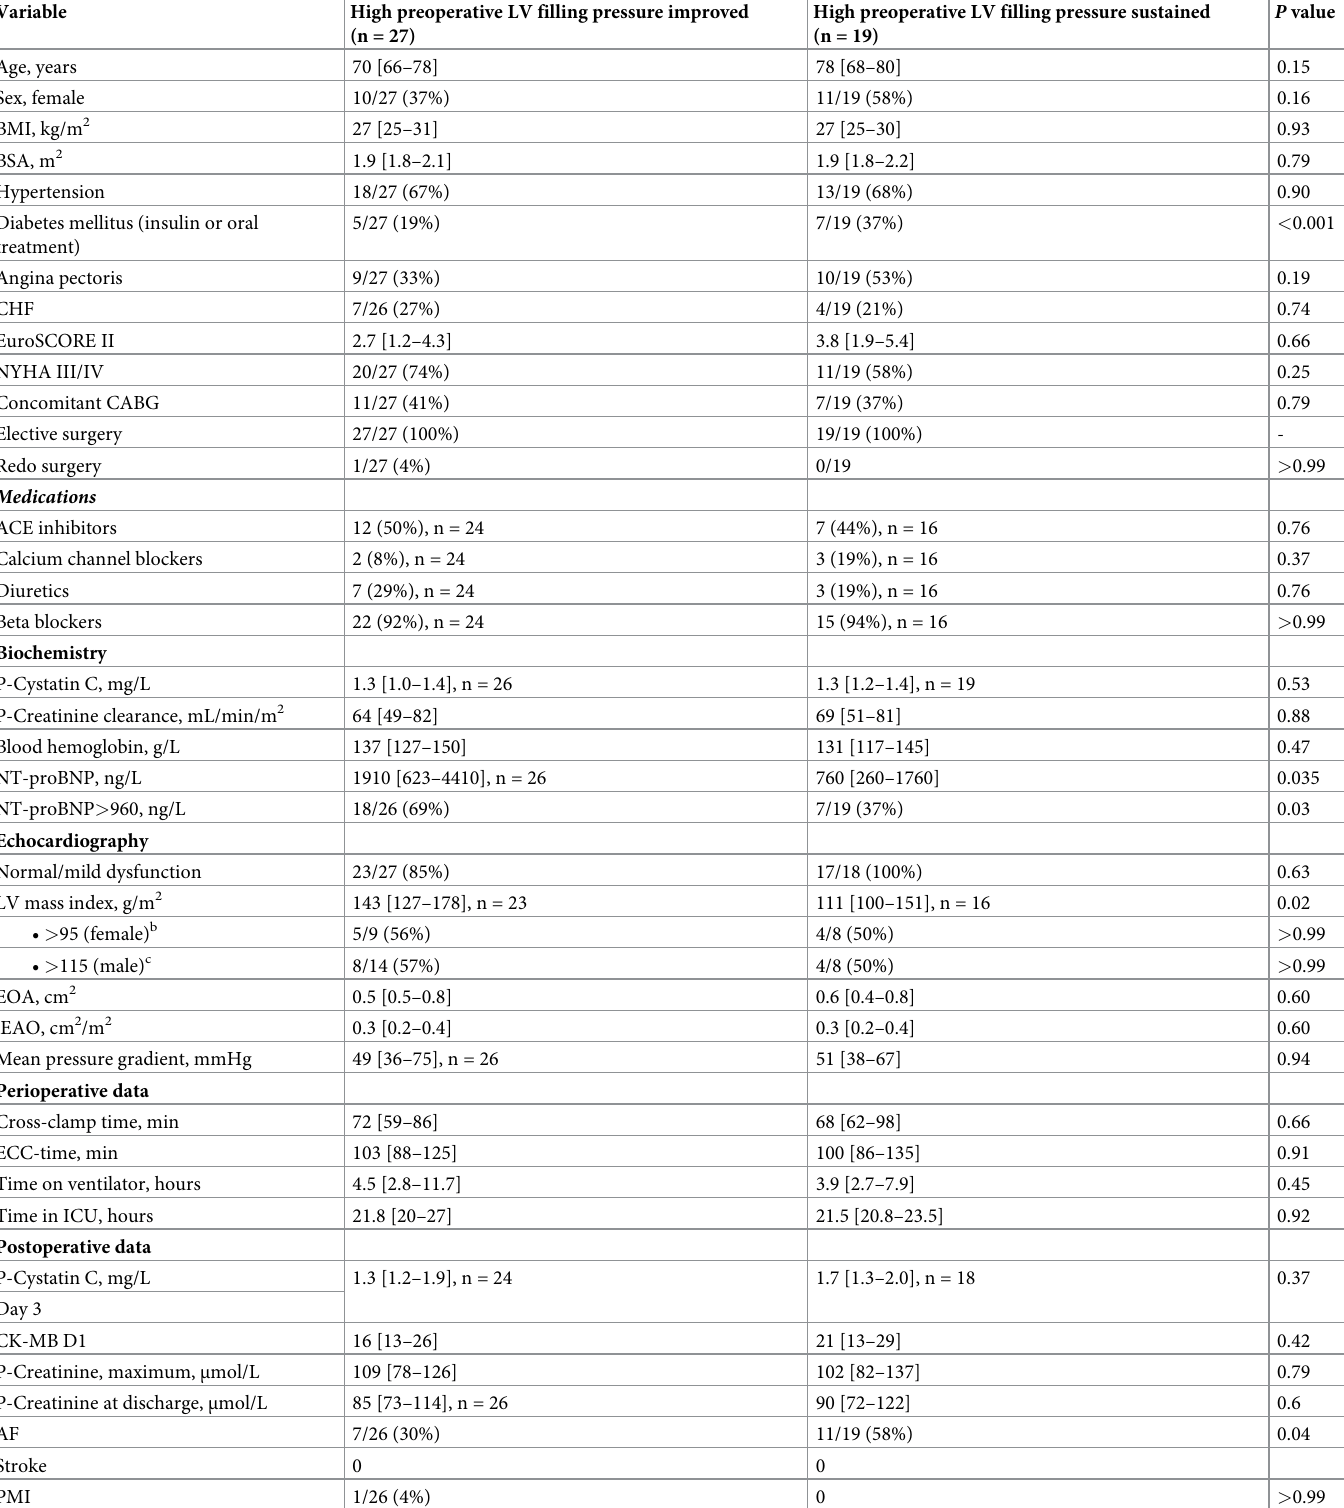
Table 4. Data regarding patients with preoperative high filling pressure a